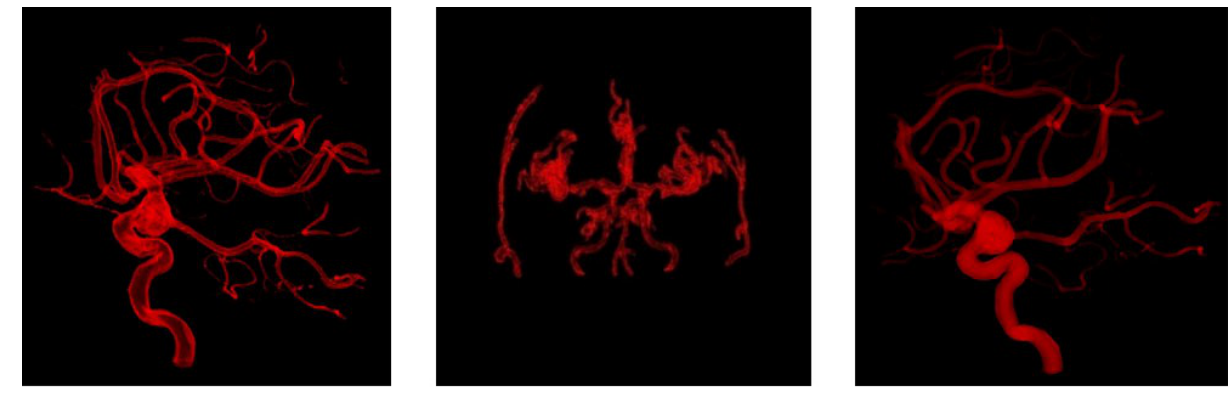
Figure 11. Volume rendering results of cerebral vessels. From left to right: The contour enhancement based on gradient; The contour enhancement based on curvature; The boundary enhancement based on depth.